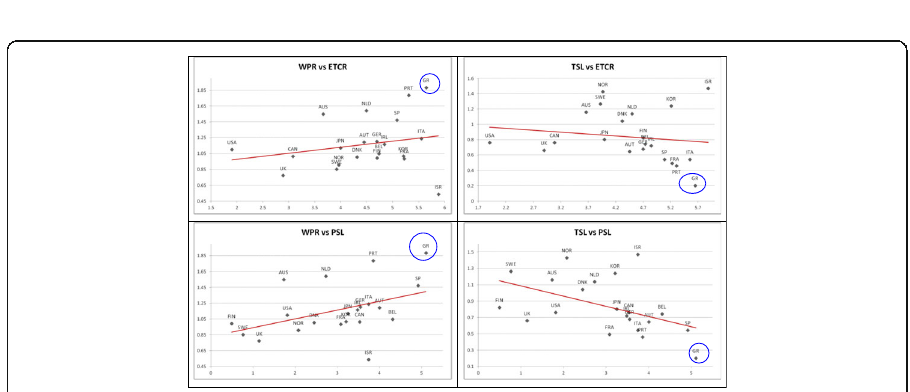
Fig. 11 Competition conditions. Note : (i) Median values (maximum time span 1970 – 2010) and (ii) the red line is the linear regression